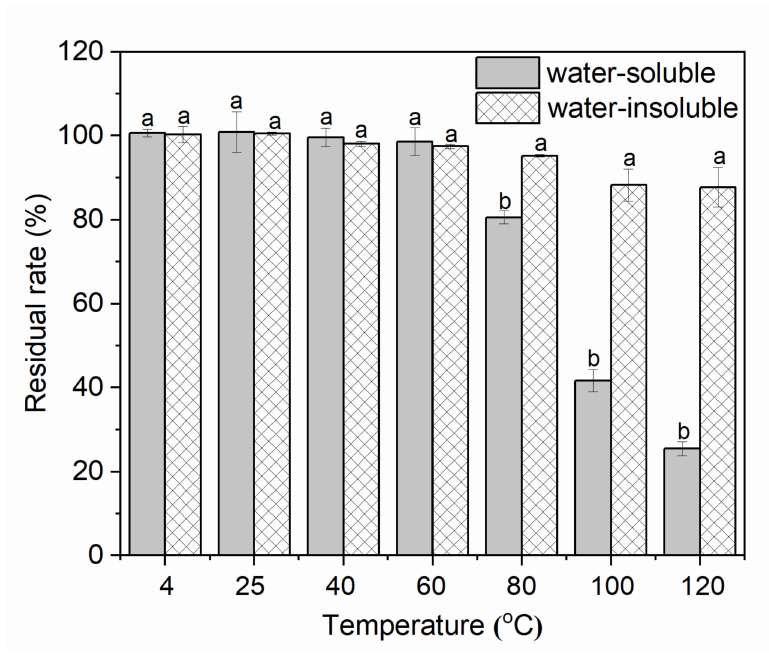
Figure 10. Temperature stability of water-soluble and water-insoluble gardenia blue pigments (residual rate). Different latters mean there is a significant difference ( p < 0.05). Table 9. Temperature stability of water-soluble and water-insoluble gardenia blue pigments (color properties). Temperature